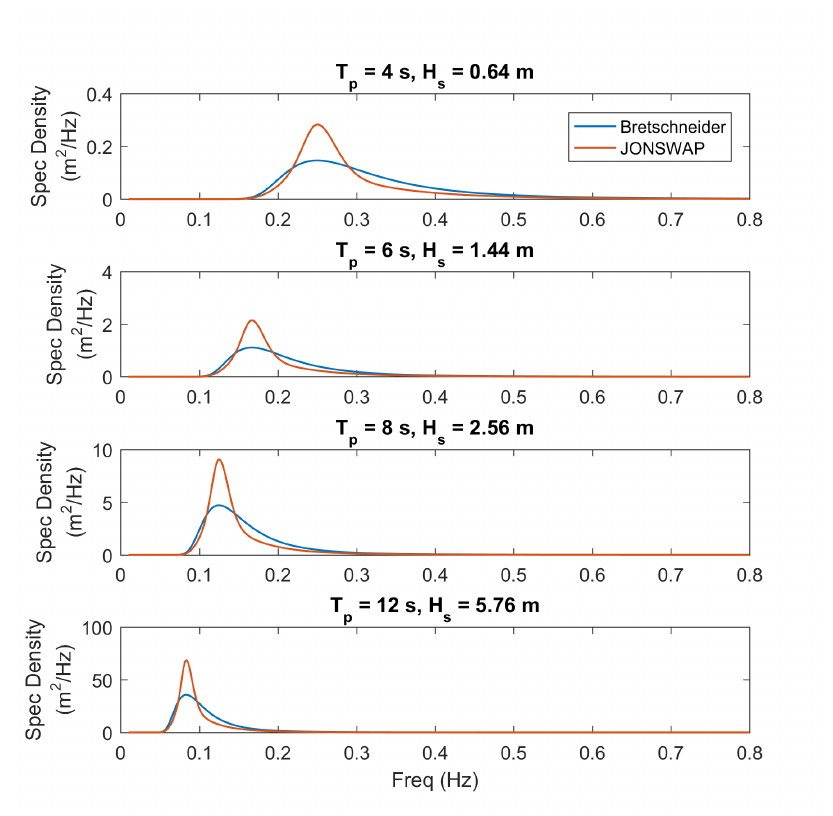
Figure 3. Bretschneider and JONSWAP wave spectra used for irregular wave